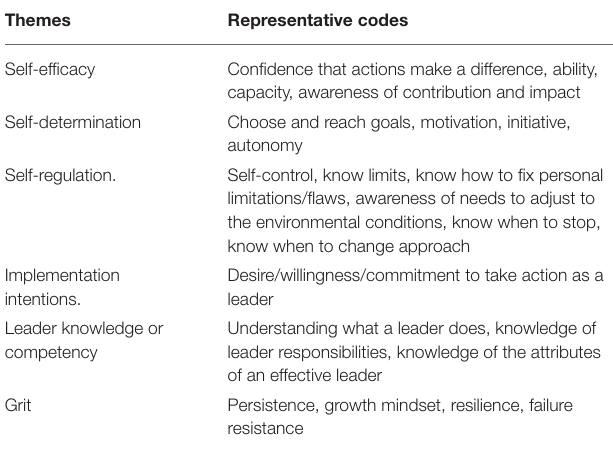
TABLE 1 | Themes and representative codes for leader